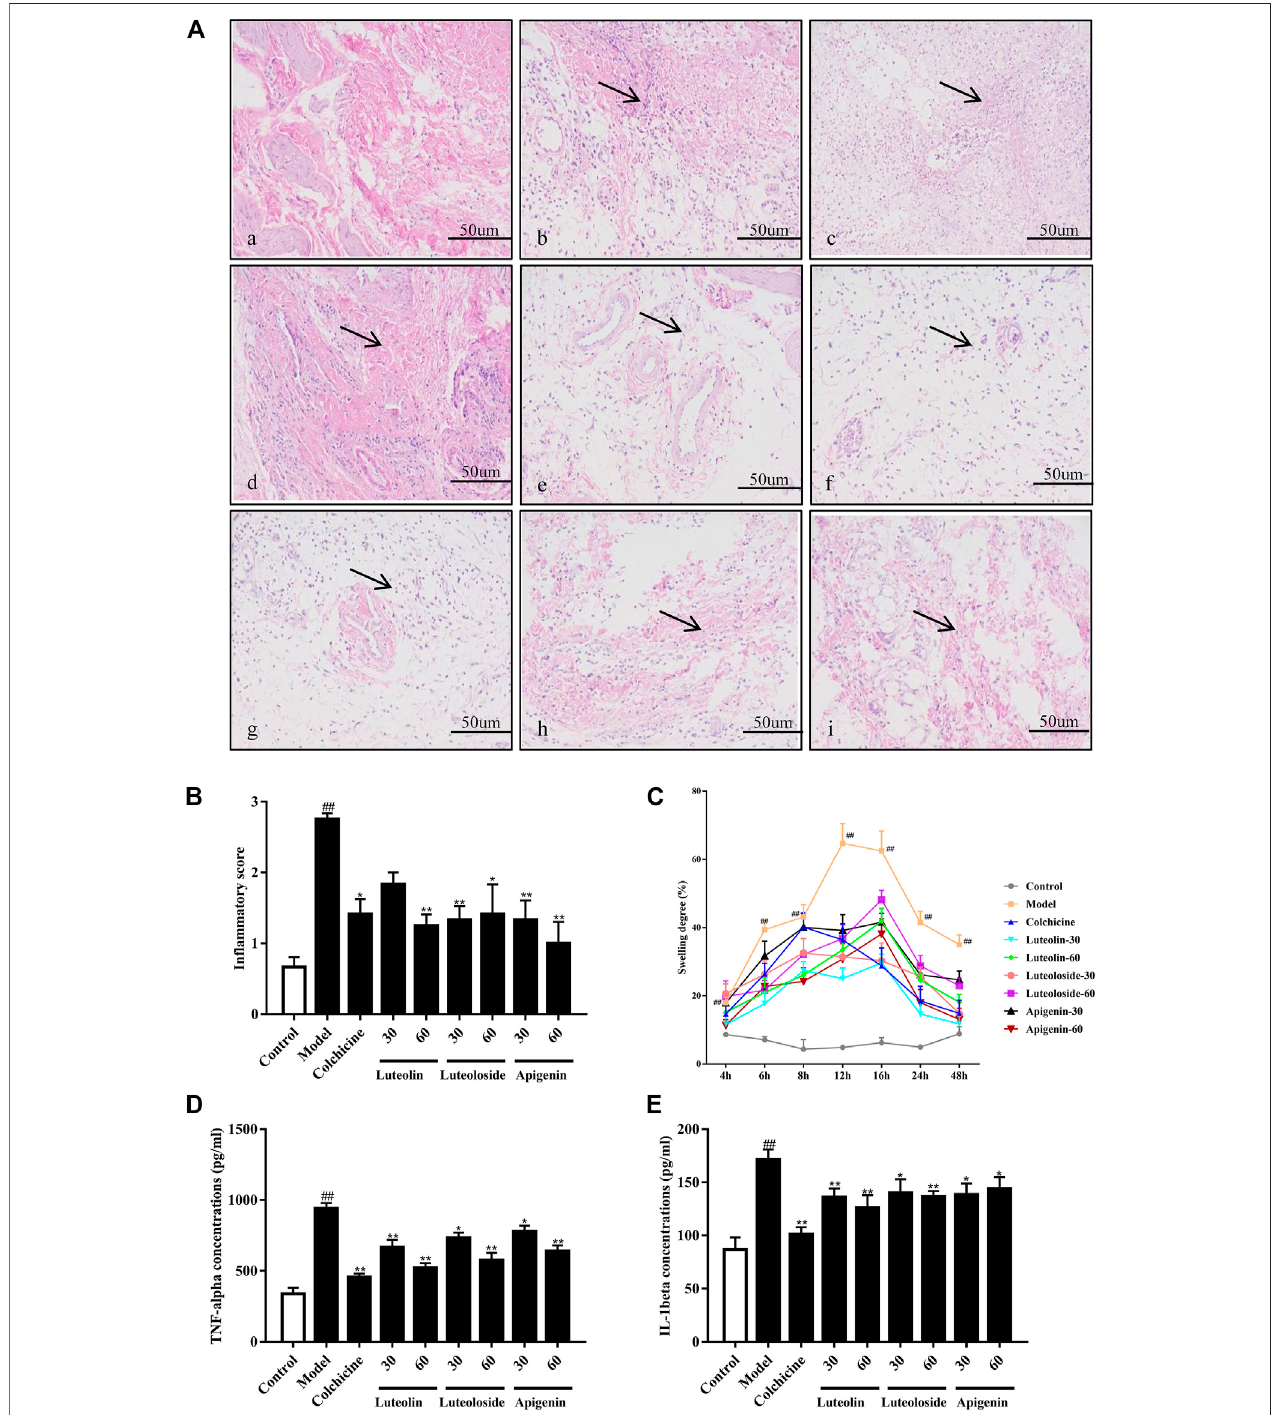
FIGURE 2 | The effects of the active fl avonoids luteolin, luteoloside, and apigenin attenuated monosodium urate (MSU) crystal-induced gouty arthritis of rats. Representative images of hematoxylin and eosin (H&E) staining (A) of synovial tissue 48 h post injection in (a) control-vehicle; (b) MSU-vehicle (Model); (c) MSU- colchicine; (d) MSU-luteolin at 30 mg/kg; (e) MSU-luteolin at 60 mg/kg; (f) MSU-luteoloside at 30 mg/kg; (g) MSU-luteoloside at 60 mg/kg; (h) MSU-apigenin at 30 mg/kg; (i) MSU-apigenin at 60 mg/kg. The black arrow indicates the in fl ammatory in fi ltration in synovial tissue. Scale bar was equal to 50 μ m. (B) The in fl ammatoryscoreofsynovialtissuebasedonH&Estaining( n (cid:2) 4). (C) Thejointswellingatdifferenttimepoints. (D) Serumtumornecrosisfactoralpha(TNF- α )levels. (E) Serum interleukin-1 beta (IL-1 β ) levels.